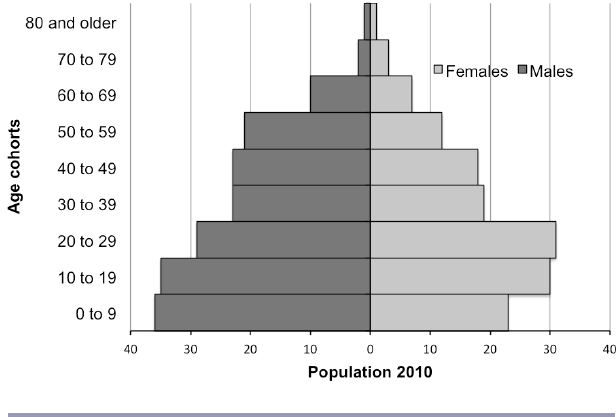
Fig. 5. Age and sex structure of the Anaktuvuk Pass population, 2010. Source: U.S. Census Bureau (2012: summary file 1 computer